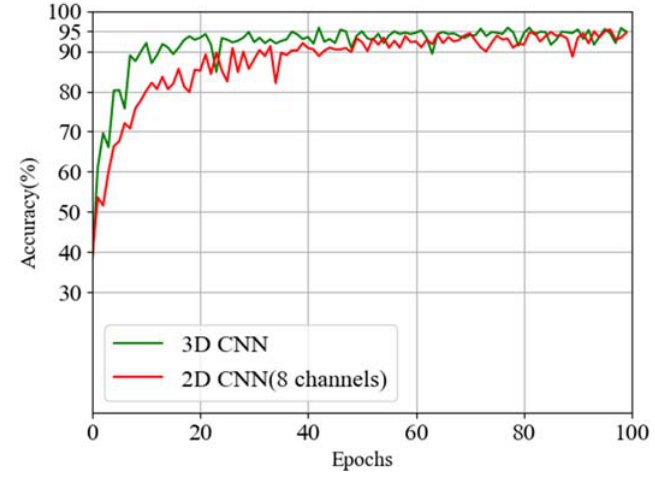
Figure 13. Two accuracy curves of using only Range–Doppler data as input.